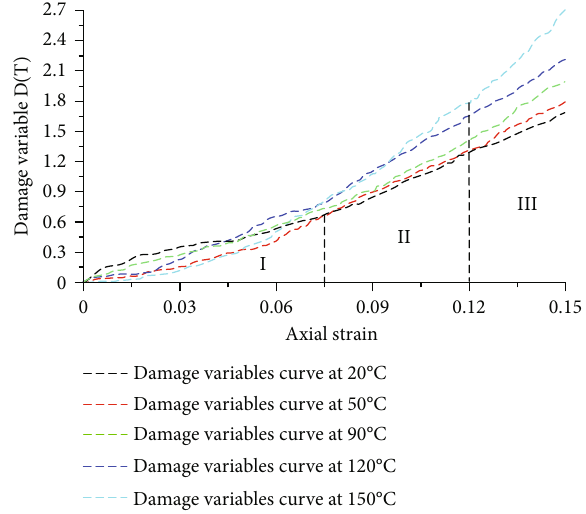
Figure 13: Variation curves of damage variables with axial strain at di ff erent